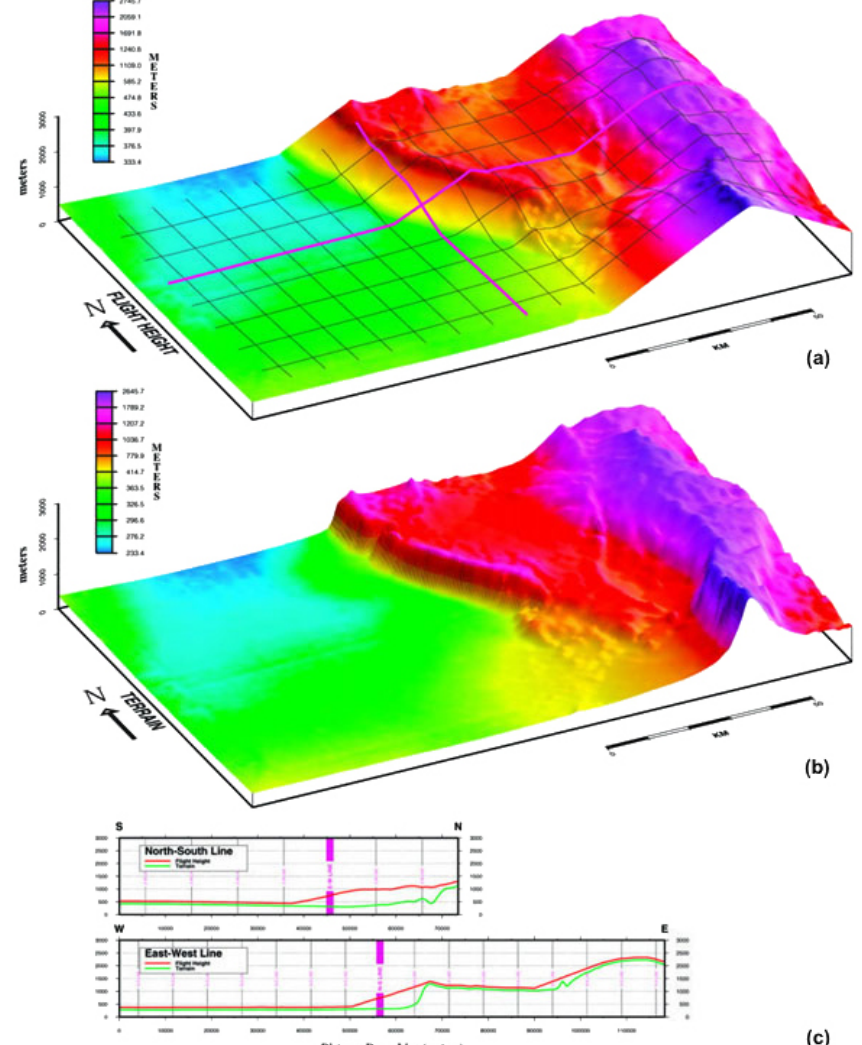
Figure 14. (a) Drape model applied to the acquisition and control lines, (b) topography of the terrain, and (c) results of an acquisition line flight with drape (source: (n.d.), http://www.terraquest.ca/wp-content/uploads/2014/05/surveycontours.jpg, last access: October